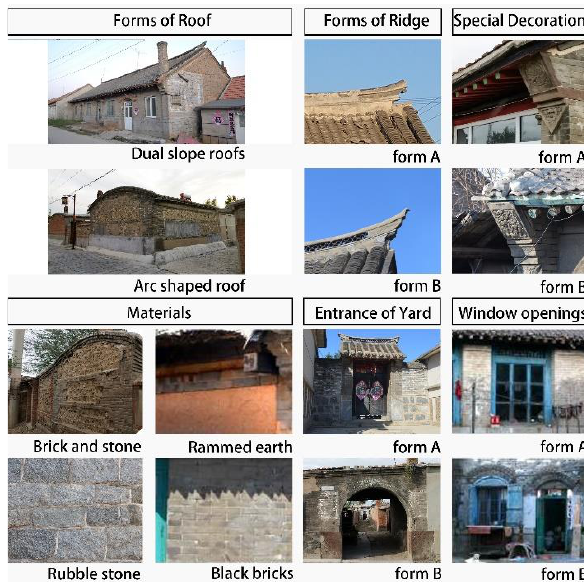
Figure 1. Traditional elements of historical residences in Liaoning Province. Photo by Li Bing and Xing Zhenpeng, 2016–2019.